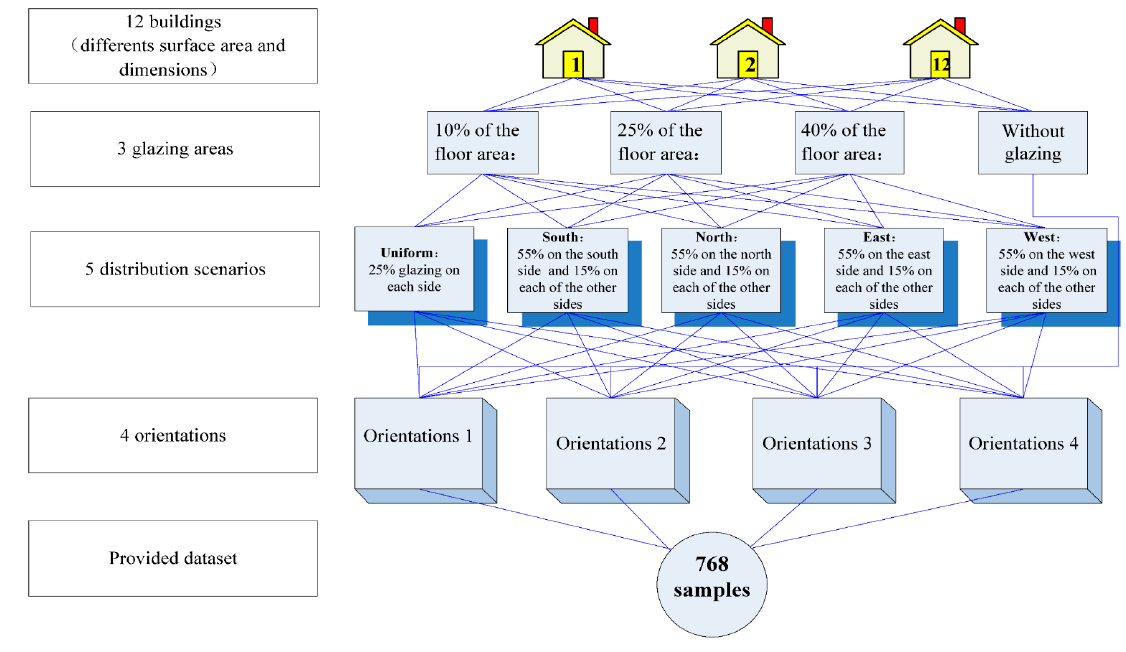
Figure 1. Graphical view of data preparation.